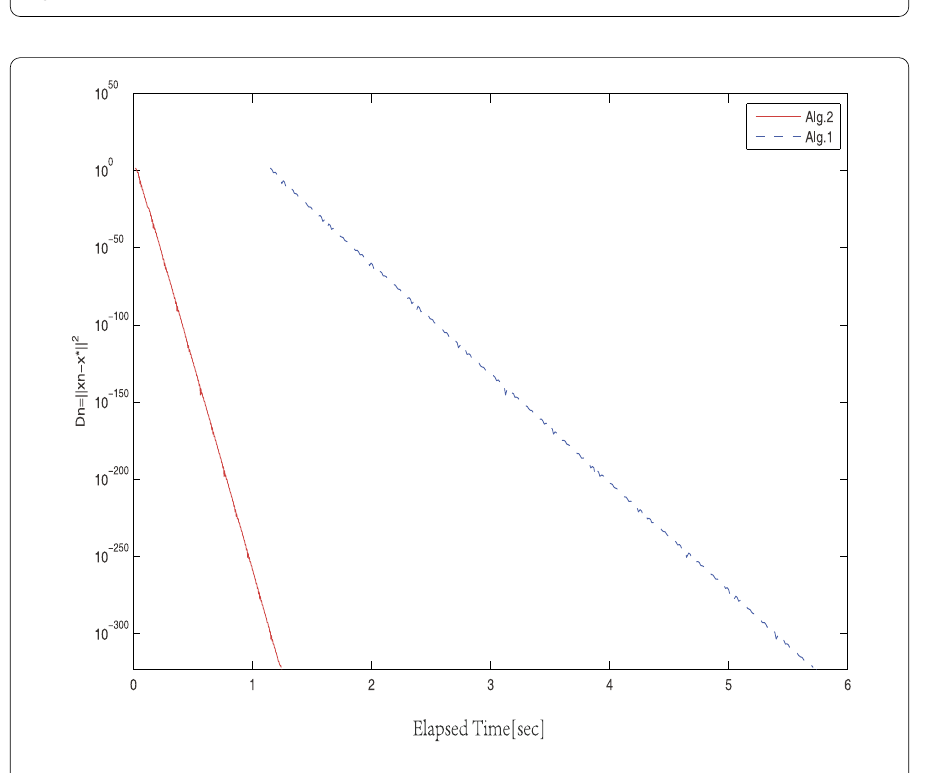
Figure 2 Experiment with m = 20 for Example 3